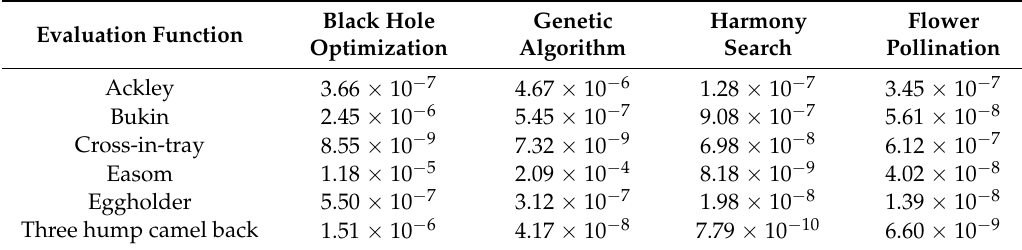
Table 1. Performance analysis of various heuristic algorithms: error values in the case of six benchmark functions after 50 iteration